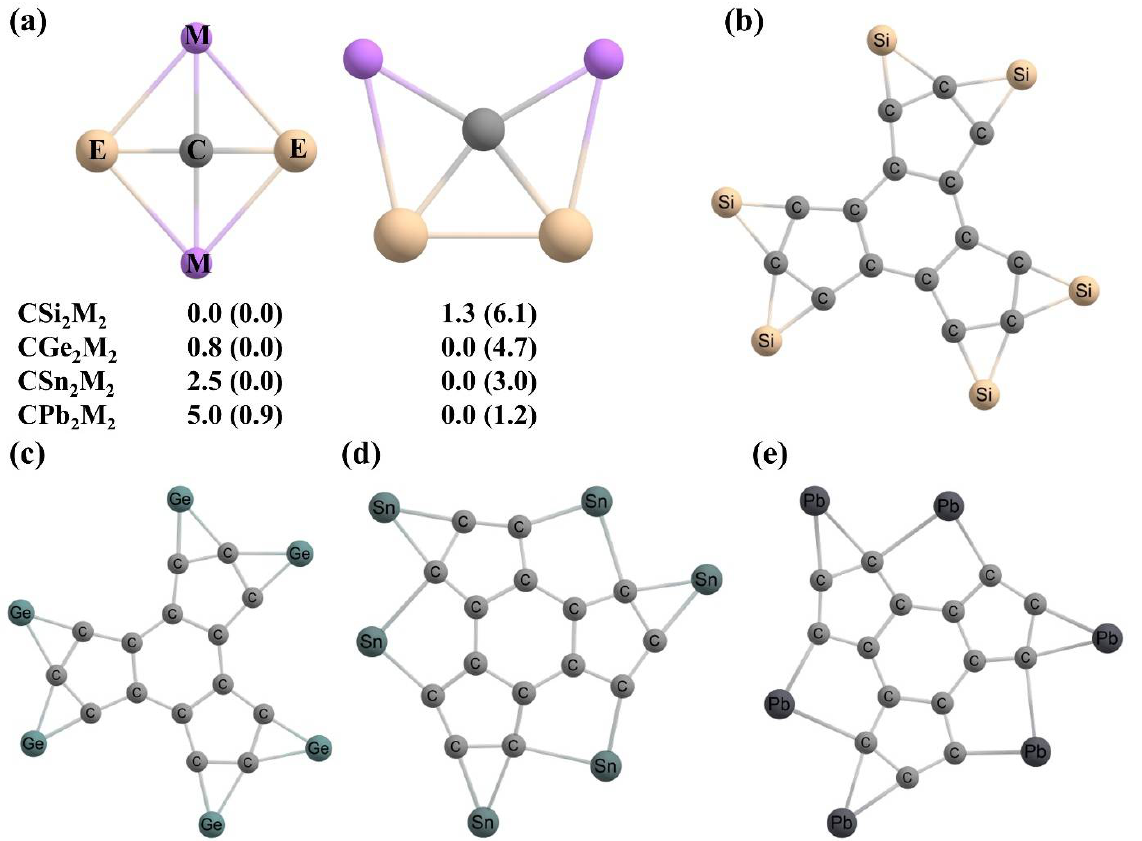
Figure 16. ( a ) The structure and relative energies (kcal mol −1 ) of the global minima and second stable isomers of CE 2 M 2 (E = Si–Pb, M=Li, and Na) at the CCSD(T)/def2-TZVP level. The values without and within parentheses correspond to clusters with Li and Na, respectively. The lowest energy structures of ( b ) Si 6 C 15 , ( c ) Ge 6 C 15 , ( d ) Sn 6 C 15 , and ( e ) Pb 6 C 15 systems.